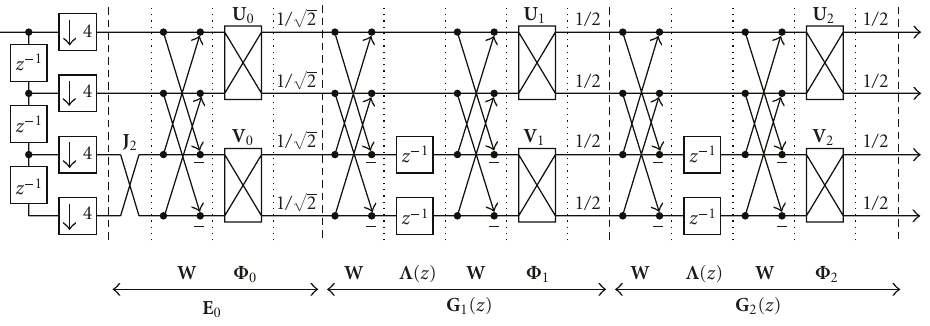
Figure 2: Conventional lattice structure for 4-channel LP PUFB ( N = 3).